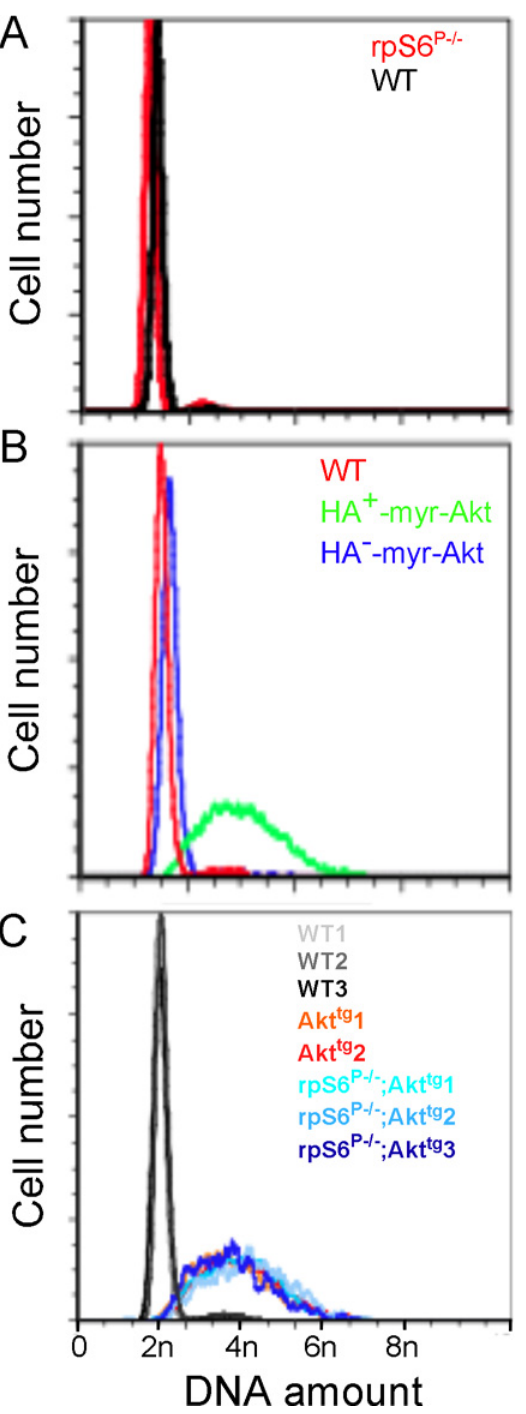
Fig 3. Constitutive expression of Akt induces polyploidy regardless of the rpS6 phosphorylation status. A. rpS6 deficiency does not affect ploidy in β -cells. Islets were isolated from wild-type (WT) and 2 month-old Akt tg mice. Dissociated islets were fixed, permeabilized, immunostained for Insulin, HA, Ki67 and Hoechst before FACS analysis. The DNA content of 5,000 to 10,000 quiescent β -cells (insulin-positive, Ki67-negative) was measured by FACS analysis. B. 5,000 quiescent (Ki67-negative) β -cells (insulin-positive) that express myr-Akt (HA-positive) are polyploidy, whereas their HA-negative counterpart shows mostly a diploid profile as wild-type β -cells. C. rpS6 deficiency does not affect the ploidy profile of myr-Akt